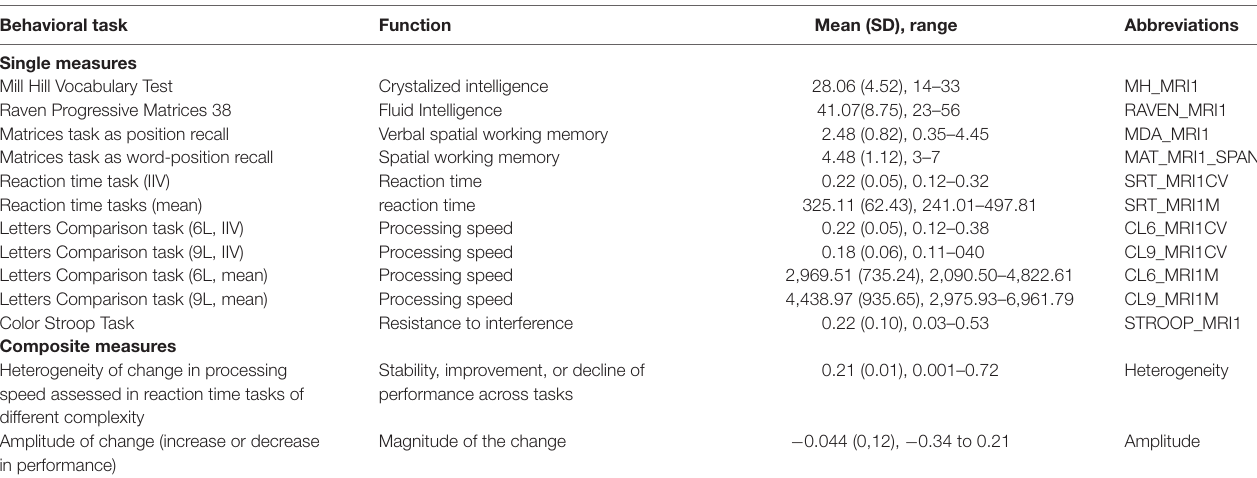
TABLE 2 | Behavioral measures and corresponding cognitive